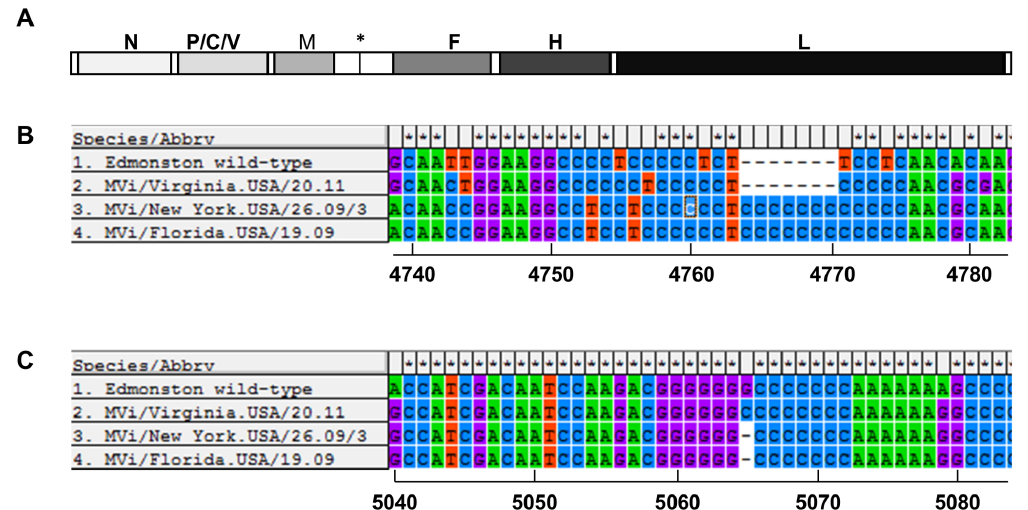
Figure 1. Location of insertions and deletions in the M-F UTR of MVi/New York.USA/26.09/3 and MVi/Florida.USA/19.09. A. Schematic representation of the MeV genome. The genome is depicted in the positive sense antigenomic orientation. Coding regions of each gene are in shades of grey, non-coding regions are white. Asterisk marks position of M-F intergenic trinucleotide at nucleotides 4872–4874. B. Insertion of 7 nucleotides in cytidine-rich region between nucleotides 4751–4775. C. Deletion of 1 nucleotide between nucleotides 5059–5072. The alignment was generated with MEGA5.10. Numbers under the alignment indicate nucleotide positions in aligned full-length genomes.